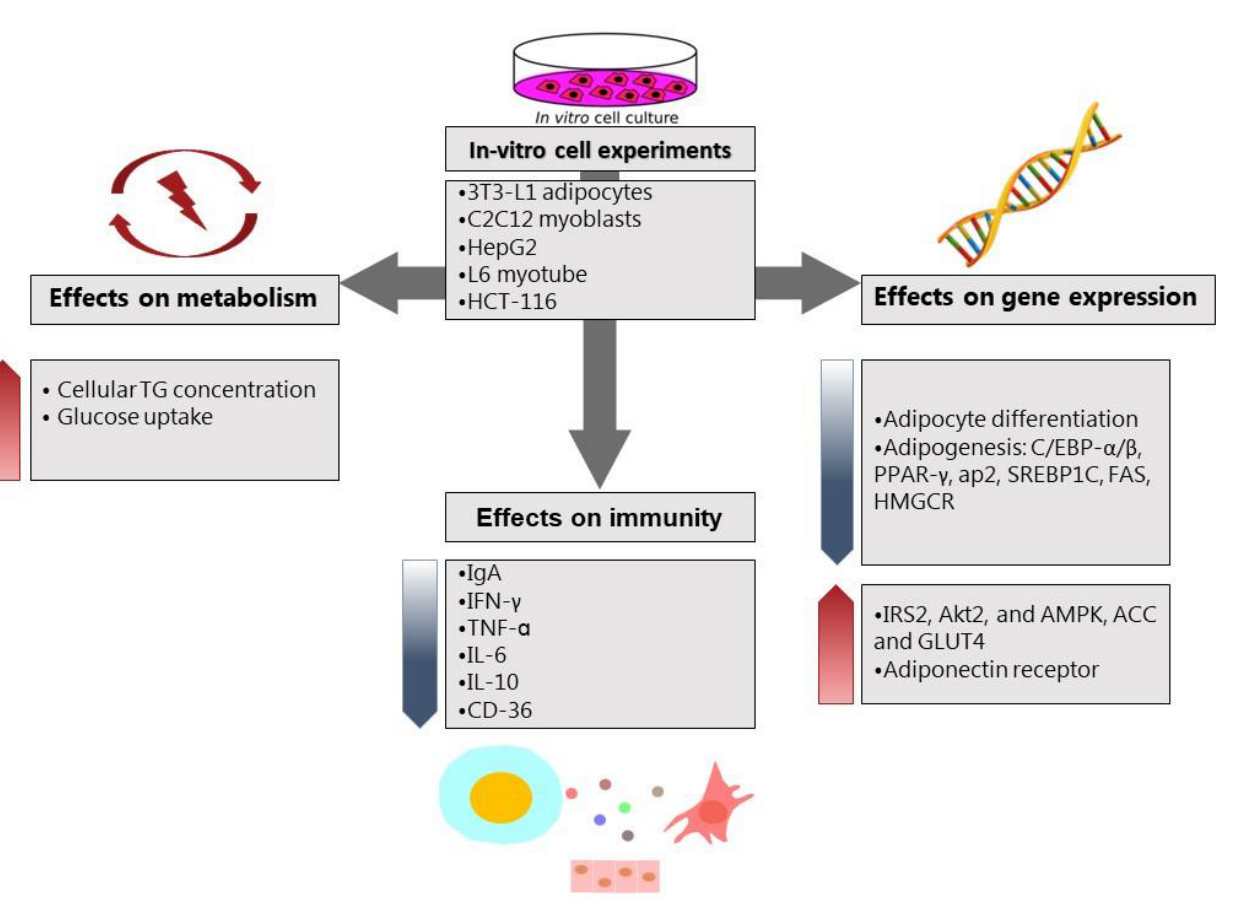
activated protein kinase, ACC: acetyl-CoA carboxylase, GLUT4: insulin-regulated glucose trans- porter.